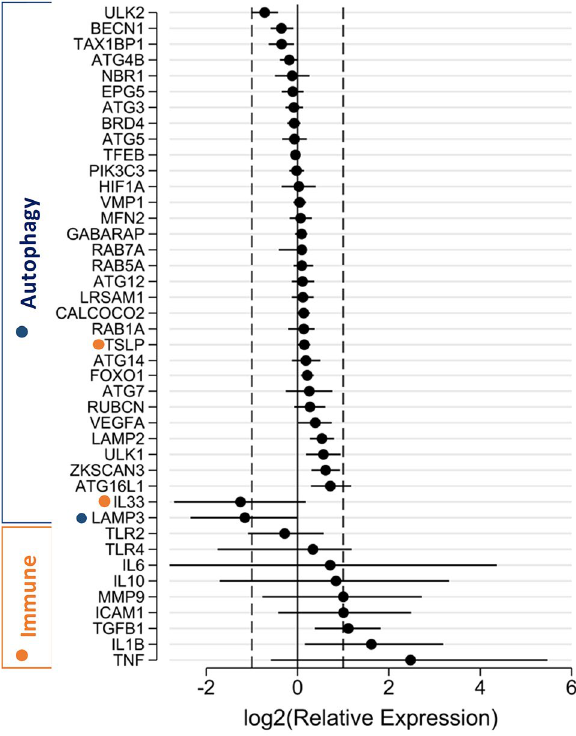
Figure 4. Differentiated nAEC and bAEC exhibit high variation in inflammatory gene activity vs those governing autophagy. Differentiated ex vivo models of the nasal and bronchial airway epithelium were assessed for the relative abundance of inflammatory and autophagy transcripts (32 days culture). Magnitudes are expressed as nAEC vs bAEC (less/more transcript abundance in nAEC-derived cultures to the left/right side of zero, respectively), and ordered to highlight transcript groups related to gene-dependent variation. Dashed vertical lines at log2(Relative Expression) at − 1.5 correspond to a fold-change of 0.35, and + 1.5 correspond to a fold-change of 2.8. Results (n = 5 participants per culture type) are normalised to three reference genes and are significant to at least P < 0.05 when 95% CI do not cross zero.